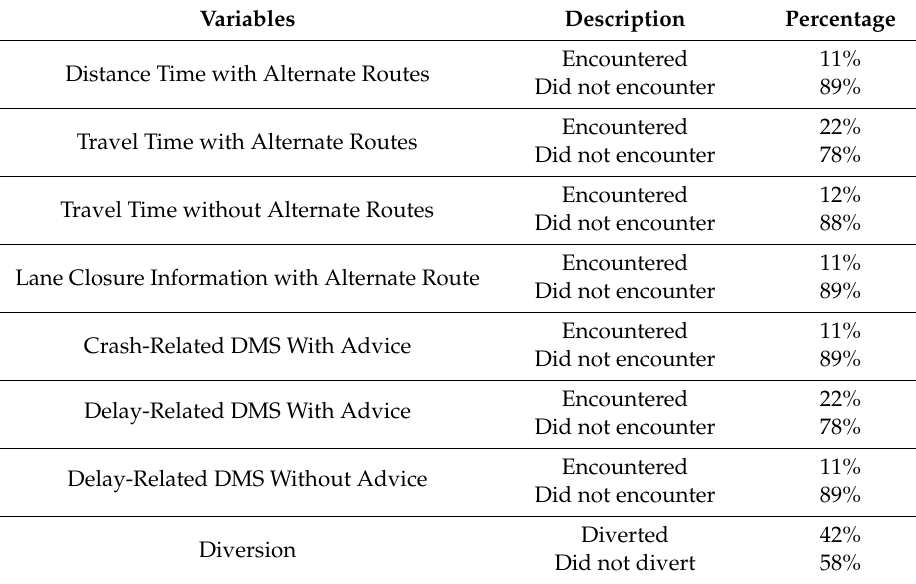
Table 4. Descriptive statistics of route diversion dataset.